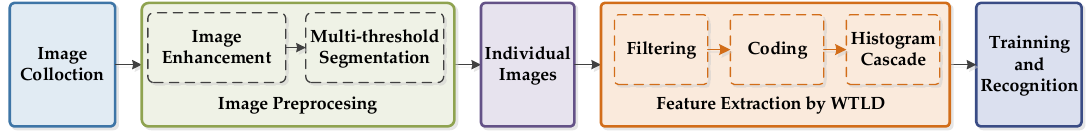
Figure 1. The flow diagram of the proposed method.